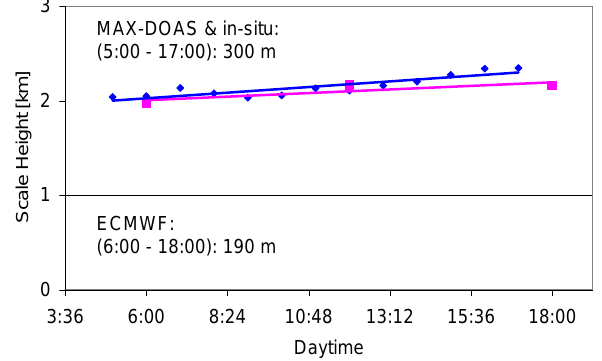
Fig. 18 H 2 O scale height calculated from the H 2 O VCD and the H 2 O concentration at the surface (Eq. 9). The blue curve show values calculated from MAX-DOAS and in-situ Fig. 18. H 2 O scale height calculated from the H 2 O VCD and the observations. The pink curve shows values calculated from ECMWF data. H 2 O concentration at the surface (Eq. 9). The blue curve shows values calculated from MAX-DOAS and in situ observations. The pink curve shows values calculated from ECMWF data.